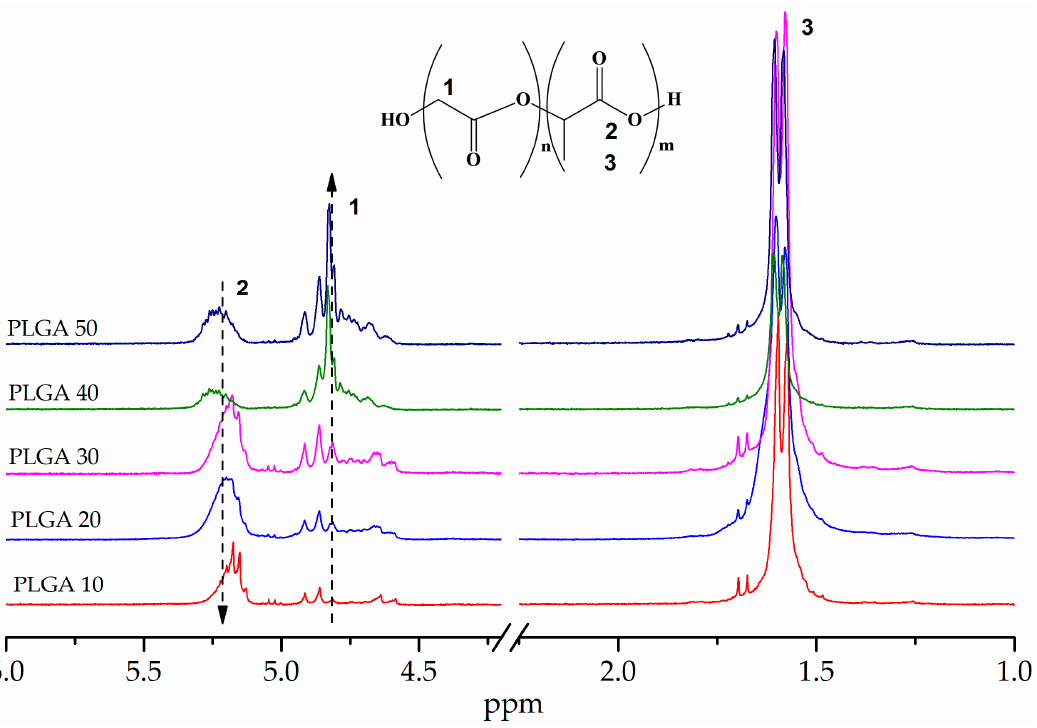
Figure 4. 1 H NMR spectrograms, an increase in the peak intensity of the chemical shift of glycolydyl unit at 4.8